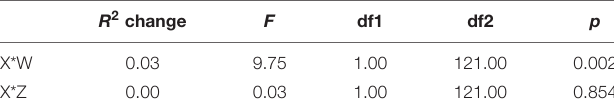
TABLE 14 | R 2 increase due to interaction (StWE).